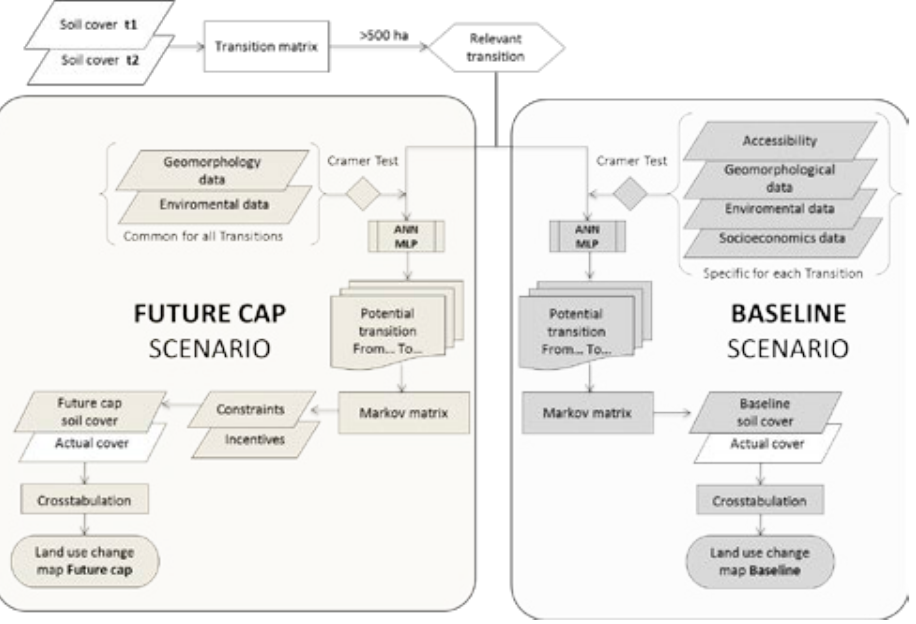
Figure 1. Applied simulation